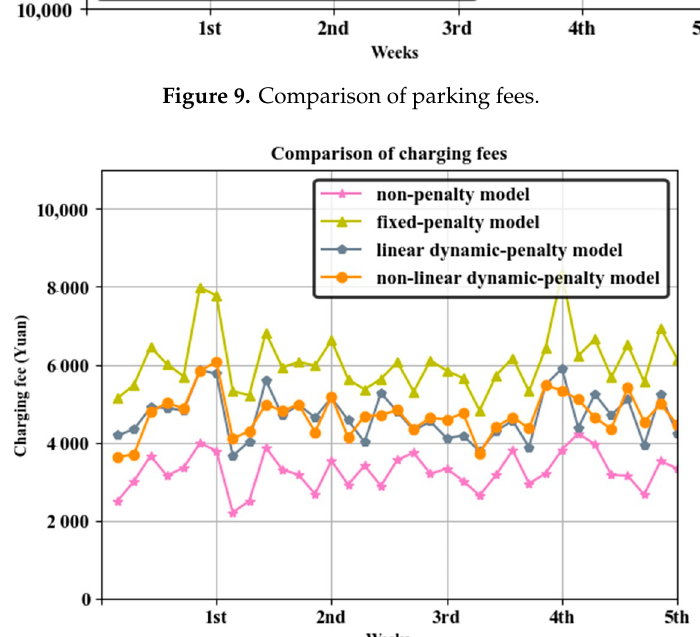
Figure 10. Comparison of charging fees.